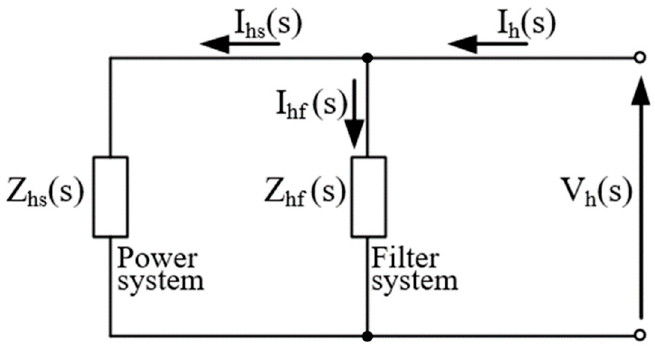
Figure 3. Conceptual 𝐻 (cid:3036)(cid:3031) (𝑠) divider.